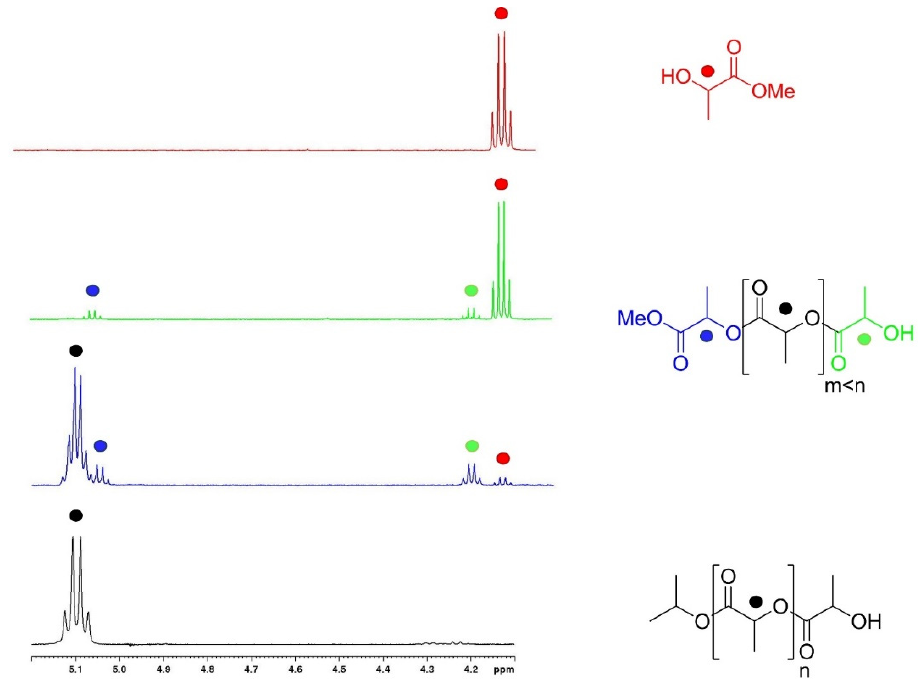
Figure 1. 1 H NMR (CDCl 3 , 400 MHz) monitoring of PLA methanolysis with assignment of internal, chain-end, and methyl lactate methine groups (run 3, Table 1). Table 1. Methanolysis of PLLA using metal amides.